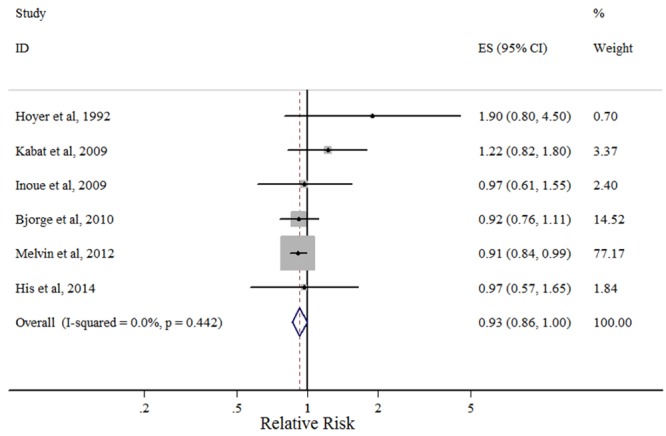
Forest plot of the highest vs. lowest categories of serum TG levels and breast cancer risk.Squares indicate study-specific relative risk estimates (size of the square reflects the study-specific statistical weight); horizontal lines indicate 95% confidence intervals (CI); diamond indicates the overall relative risk with its 95% confidence interval.